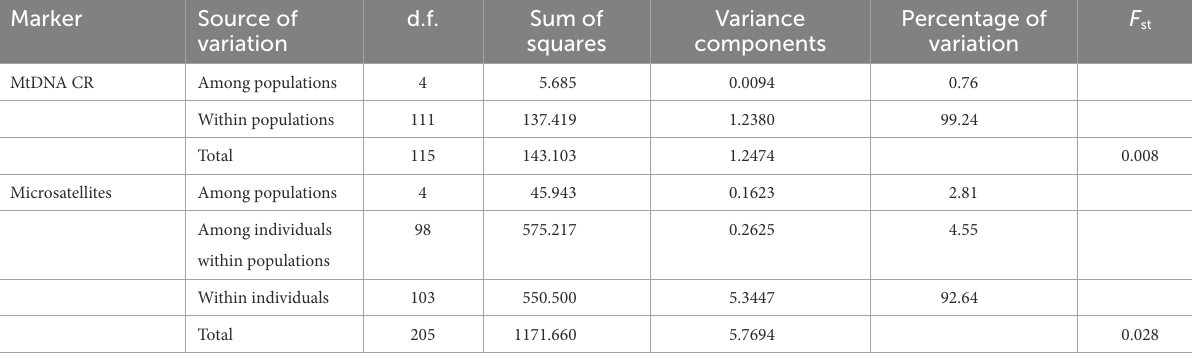
TABLE 2 Analysis of molecular variance and F st for the five local populations of Jankowski’s Bunting. Marker